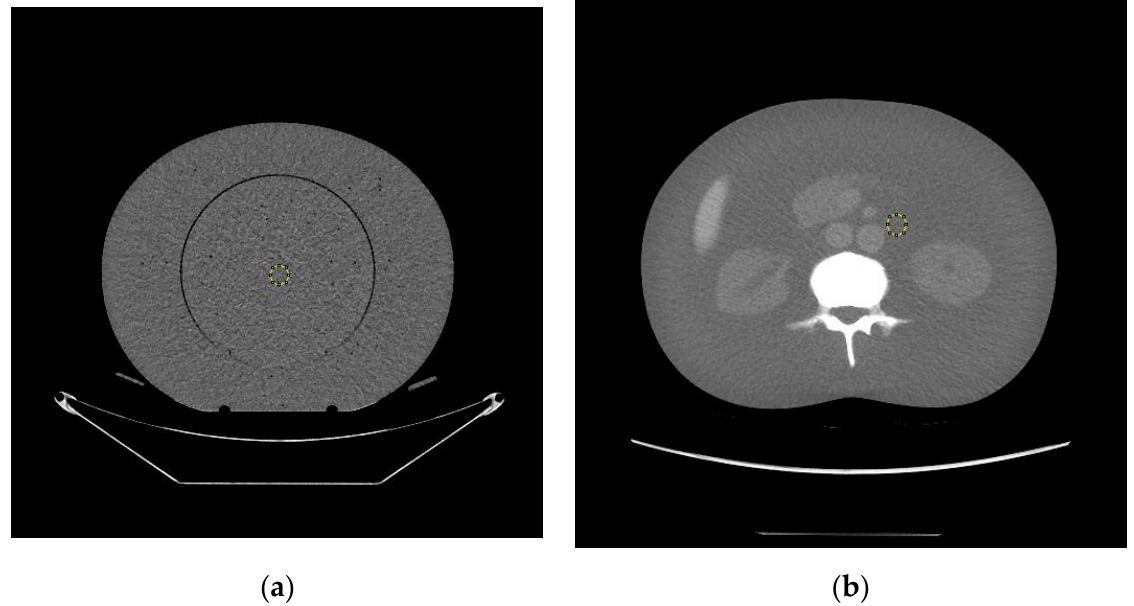
Figure 1. The central slices selected for CT number measurements of ( a ) the 062M electron density phantom; ( b ) the PBU60 anthropomorphic phantom. The central regions of interest used in this study are shown as yellow circles. The horizontal axis is termed body width and the vertical axis is termed body thickness. Both data collection and image reconstruction are 50 cm in diameter for both phantoms.